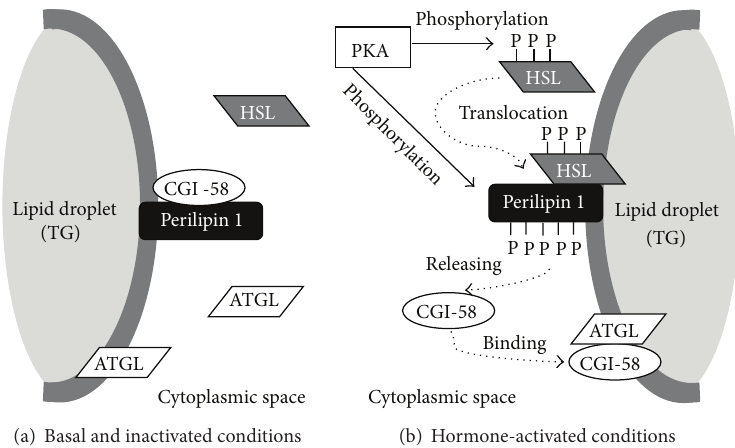
Figure 3: Under basal and inactivated conditions, perilipin 1 and CGI-58 form a complex on the surface of lipid droplets (a). On the other hand, PKA activation leads to the phosphorylation of both HSL and perilipin 1, resulting in HSL and perilipin 1 forming a complex on the surface of lipid droplets. Released CGI-58 from phosphorylated perilipin 1 binds to ATGL to induce lipolysis